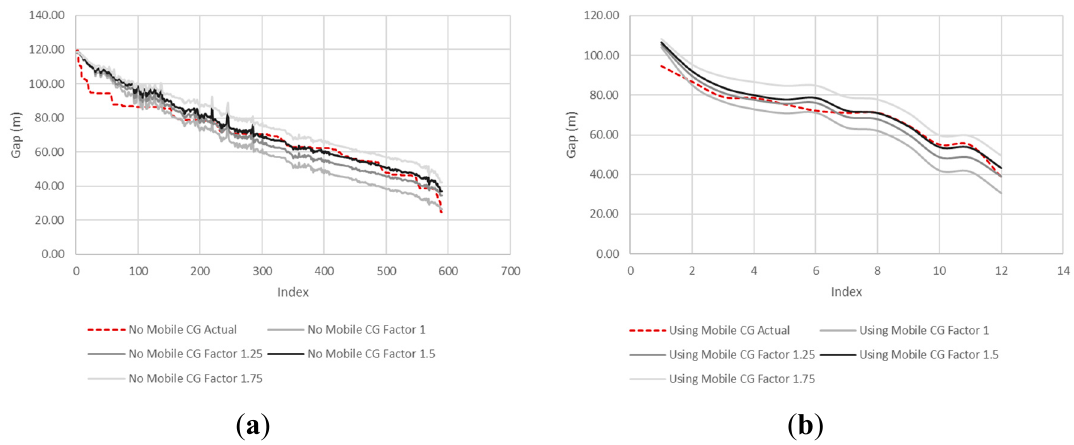
Figure 9. Comparison between actual data and simulation results per mobile phone usage. ( a ) Not using mobile phone; ( b ) using mobile phone.